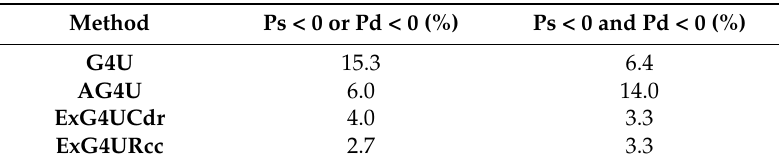
Table 6. Percentage of pixels with negative scattering powers for L-band